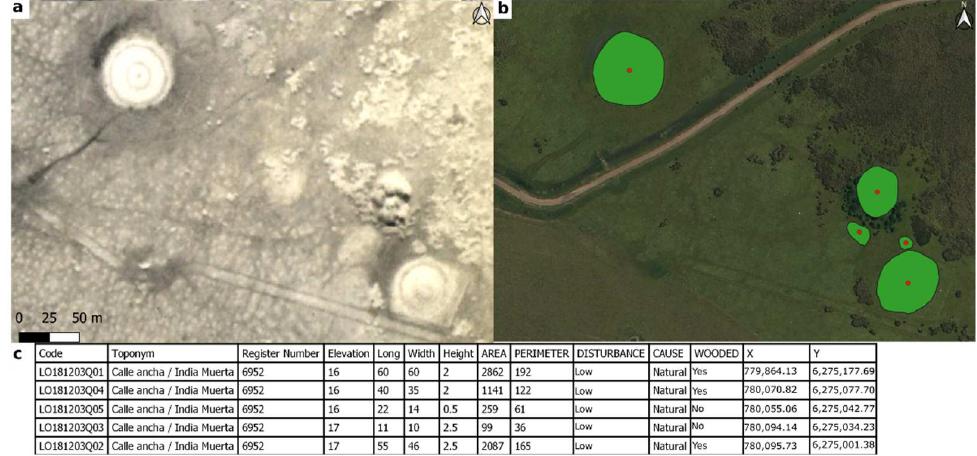
Figure 2. Documentation of mound structures. ( a ) Identified in aerial photographs from 1966 (SGM 1:20,000). ( b ) Field record of the central point and polygon. ( c ) Some of the variables recorded in the field and inputted into the GIS.